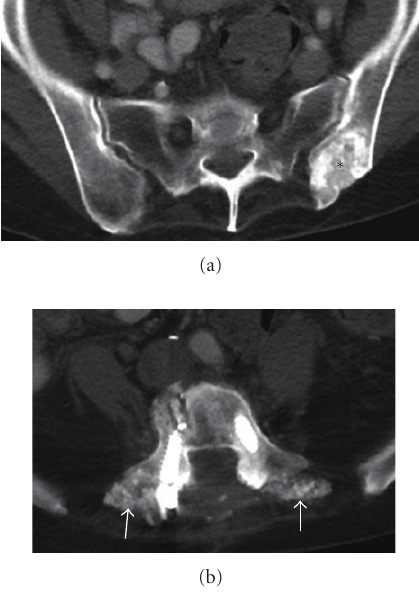
Figure 15: Bone graft donor site. Axial CT (a) demonstrates an aggressive appearing lesion in the left ilium, in a classic location of bone graft donor site. In this case bone graft material (arrows) was used in posterior spinal fusion surgery as shown in the axial CT